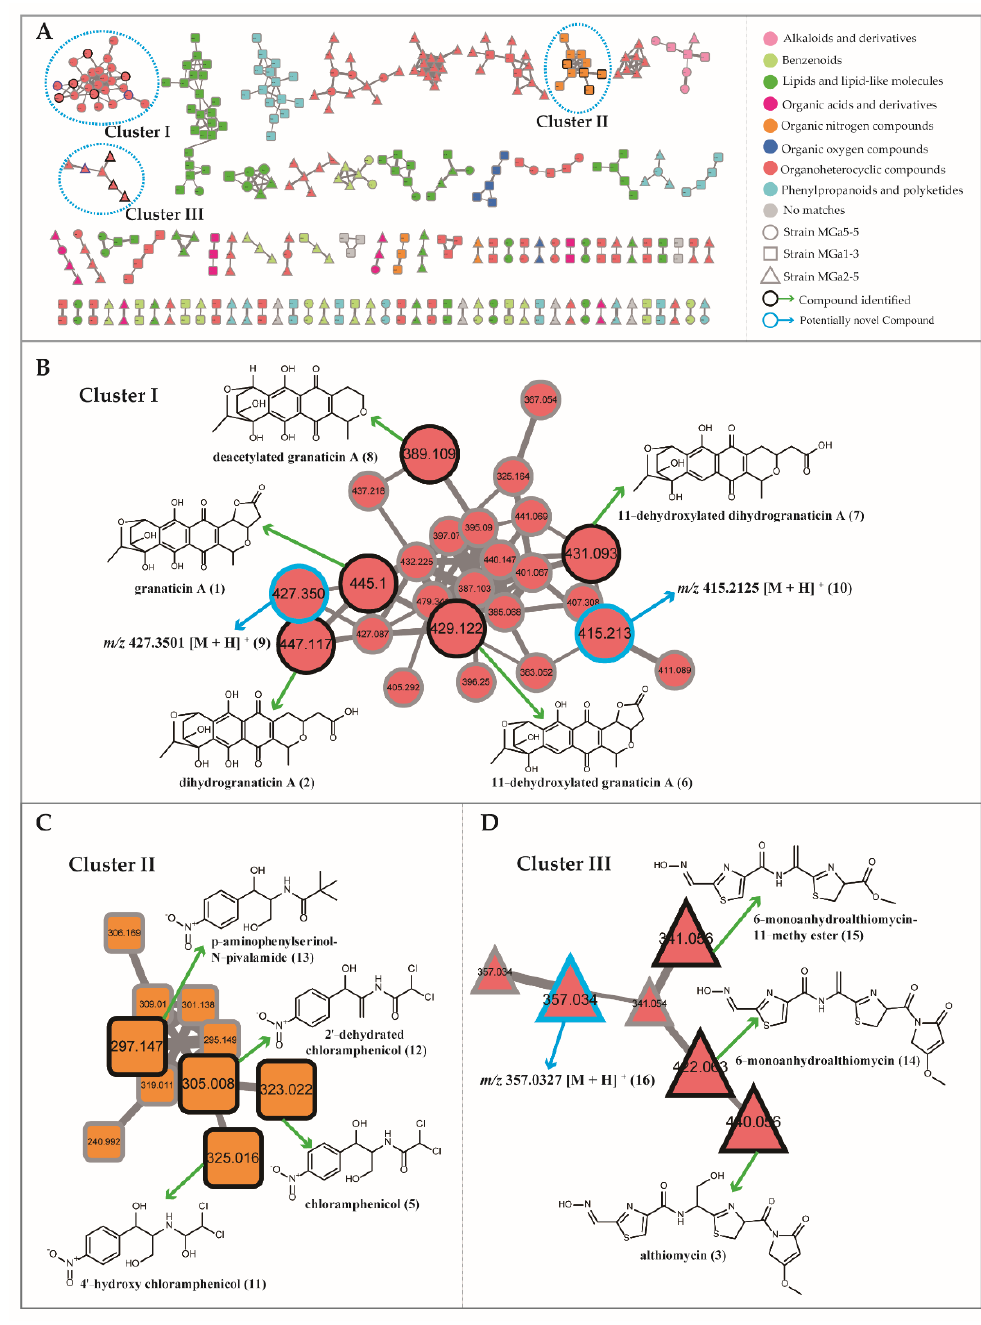
Figure 7. Enhanced molecular network for annotation of secondary metabolites from EA extracts from strains MGa5-5, MGa2-5 and MGa1-3. The molecular network generated by LC-MS/MS data was analyzed by using NAP and MolNetEnhancer workflow via the GNPS platform. ( A ) Structural annotation for the whole molecular families of three strains, wherein the color of nodes denotes the structural annotation at the superclass level by NAP. ( B ) Observation of molecular cluster I allows highlighting annotation of granaticin family in strain MGa5-5. ( C ) Observation of molecular cluster II allows highlighting annotation of chloramphenicol family in strain MGa1-3. ( D ) Observation of molecular cluster III allows highlighting annotation of althiomycin family in strain MGa2-5.